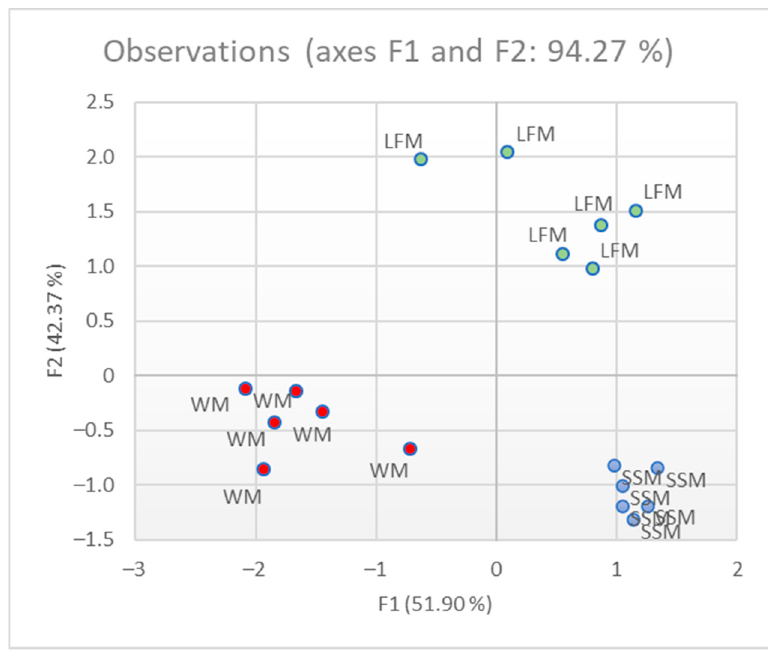
Figure 9. PCA analysis to distinguish whole milk (WM, red dots), semi-skimmed milk (SSM, blue dots) and lactose-free milk (LFM, green dots) within brand 3. The PCA has been performed starting from the three variables C , R and Q .